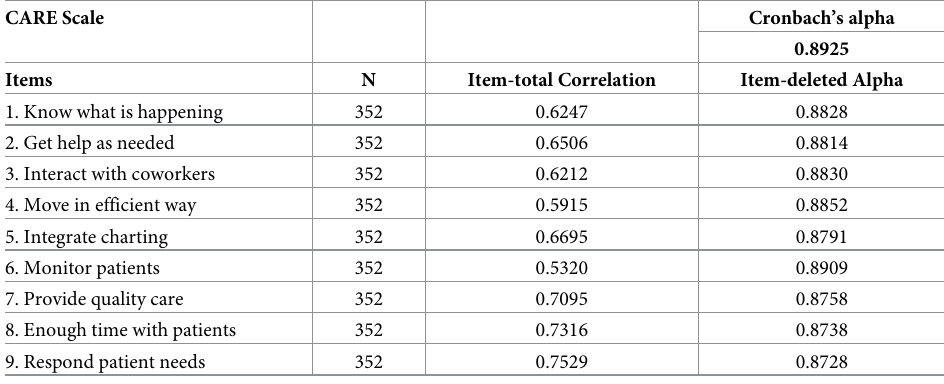
Table 11. Phase 4 Cronbach’s coefficient alpha and item-total correlations.